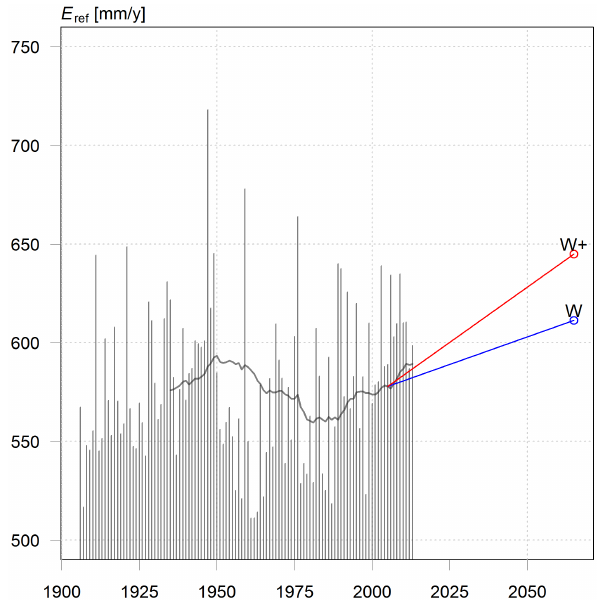
Figure 1. Yearly and 30-year moving average E ref according to Penman–Monteith for De Bilt, the Netherlands, and projected E ref values for the period 2036–2065. Projections are based on na- tional climate scenarios (Van den Hurk et al., 2006) developed by the Royal Netherlands Meteorological Institute (KNMI). Two of the scenarios have been found to be most likely (Klein Tank and Lenderink, 2009) and are presented here: scenario W (blue line) and W + (red line). Both comprise a + 2K global temperature in- crease, but with, respectively, unchanged and changed ( + ) air cir- culation patterns in summer and winter. The scenarios were used to transfer the climatic conditions of 1976–2005 to the period 2036– 2065 (Van den Hurk et al.,